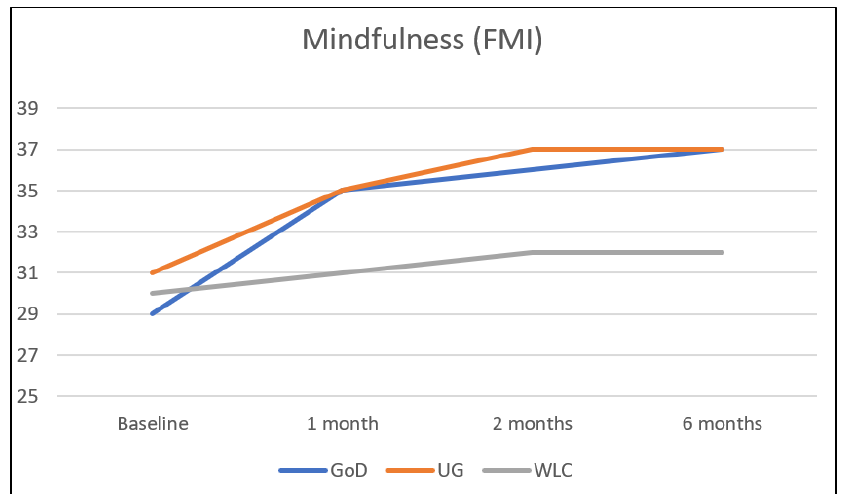
Figure 2. Primary outcome mindfulness in relation to study condition and assessment time. Table 3. Results of regression analyses (intention-to-treat). M + SD Primary Analyses Secondary Analysis